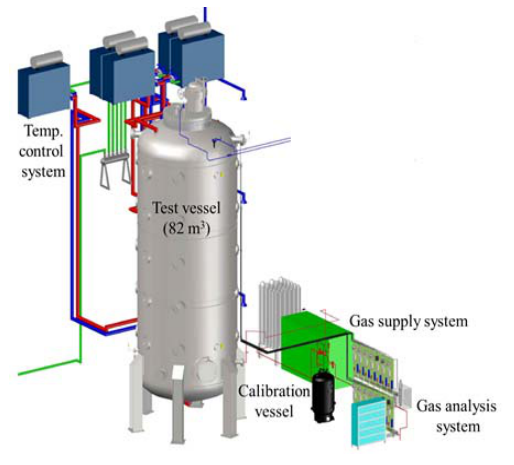
Figure 3. SAPRC test facility. Table 2. Specification of the Spray–Aerosol ‐ Recombiner ‐ combustion test facility (SPARC) test facility.